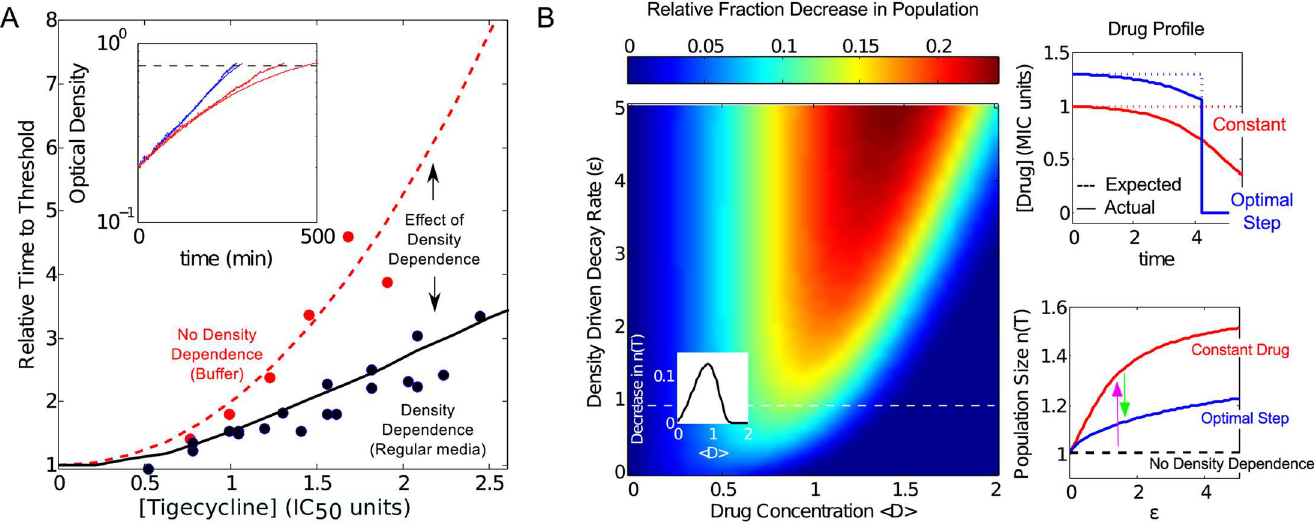
Fig 4. Density dependent growth modulates time-to-threshold and optimal antibiotic treatment for in-vitro growth model. A. Time for population to grow from OD = 0.2 to OD = 0.8 (“threshold”) in the presence of tigecycline, relative to time with no drug. Curves represent theoretical predictions with ( ε = 0.9, black, solid) and without ( ε = 0, red, dashed) density dependence. Points represent experimental measurements in regular media (black) and highly buffered media (red). Inset: comparison of theory (smooth lines) and experimental time series of optical density in regular media (blue) and buffer (red) for [tigecycline] = 1.2 (units of IC 50 ). B. Decreasein final populationsize when na ï ve dosing(upper right inset, dashed red line) at initial concentration D 0 is replaced by optimal step-like dosing (upper right inset, dashed blue line). Dashed white line: ε = 0.9, as for tigecycline. Small inset: Fraction decrease in the population as a function of < D > for tigecycline ( ε = 0.9). The step-like therapy introducesdrug at initial concentration D 0 / τ and then sets drug concentration to zero at time t = τ T. The parameter τ is chosen to minimizethe cell density n(T) at time T, the end of the treatment (0 (cid:20) τ (cid:20) 1). In the absence of density dependence,both therapies result in a time-averaged drug concentration ðh D i ¼ 1 drug concentration over time with (“actual”; solid lines) and without (“expected”; dashedlines) density dependence for na ï ve (red) and step-like (blue) dosing. Lower right inset: final population size (relative to the case with no density dependence) for the na ï ve treatment (red) and the optimal step-like treatment (blue) as a function of ε . At a given value of ε , density-dependence can significantlyincrease n(T) (magenta arrow), but the optimal step dosing can often reduce the effects by 50% or more (green arrow).